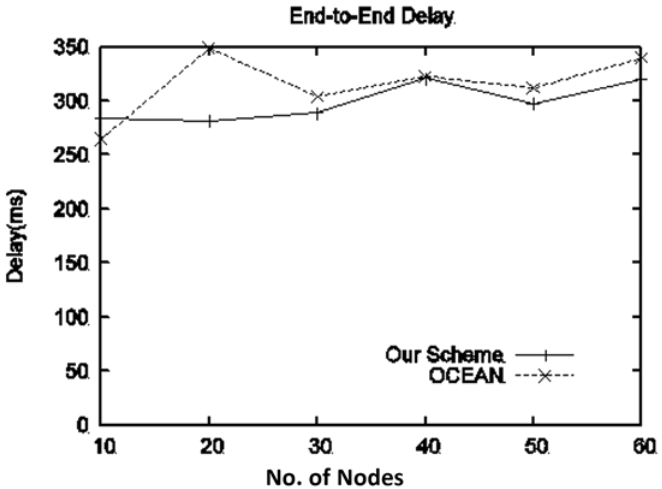
Figure 10. Scalability of the proposed scheme with respect to fixed speed, fixed selfish population, and varying number of mobile nodes.